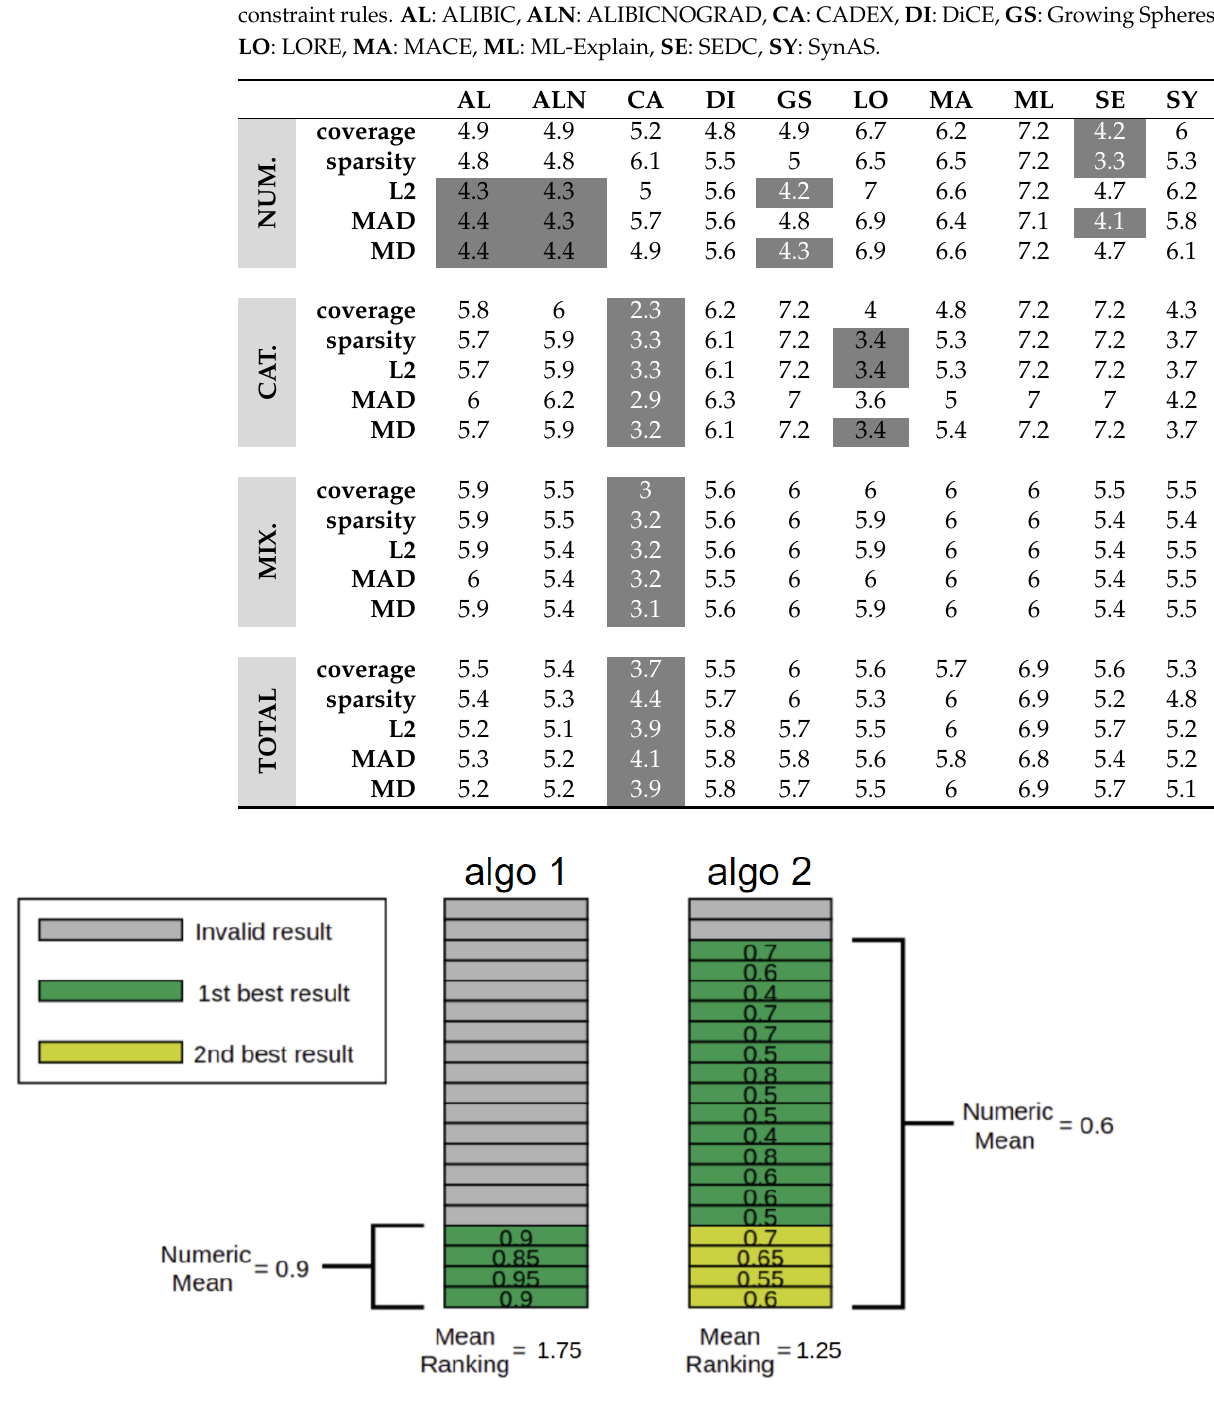
Figure 3. Example of how numeric and ranking results can have discrepancies. When calculating numerical statistical properties from results, like mean sparsity, we only consider valid (or valid and realistic) results. In the figure, this means the gray cells’ (invalid results) values are not considered in the calculation of numerical scores. Thus, analyzing algorithm